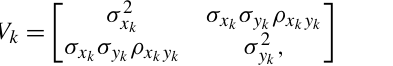
The SPINE algorithm involves minimising (cid:80) respect to the unknown, θ , a two-element column vector, { a,b } T in the line equation, y = a + bx , in order to fit the data. The residual, r k on data point k is defined below, and the function ρ is defined in Eq. (3) in the main text. The SPINE algorithm subsumes YORK